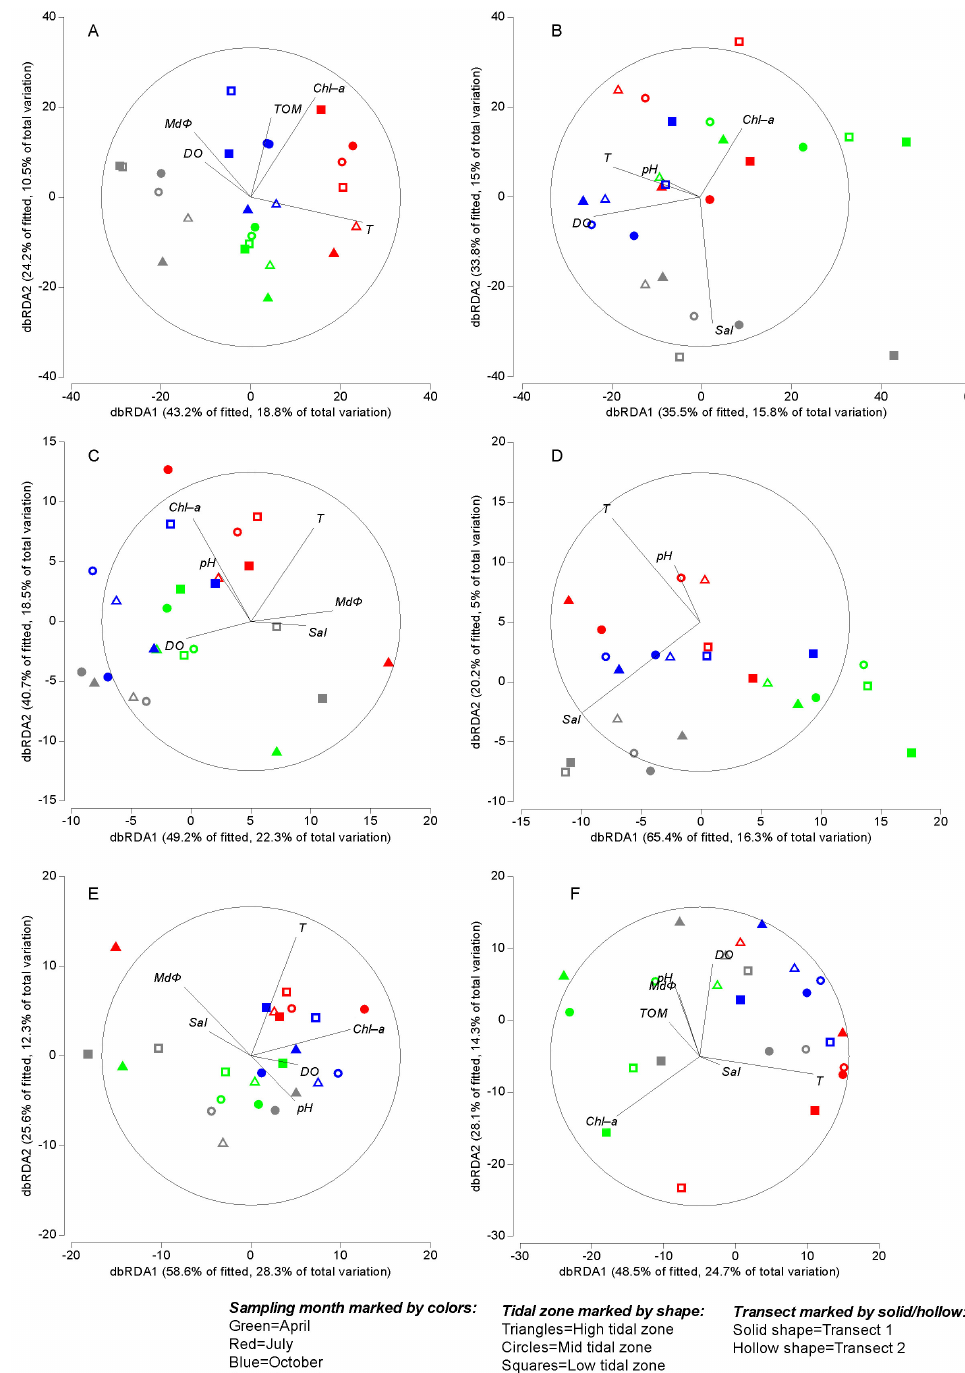
Figure 7. dbRDA ordination for the fitted model of nematode data (based on Bray–Curtis after fourth root transformation of abundances) versus environmental variables at XB ( A , C , E ) and GB ( B , D , F ) separately. ( A – B ) species composition; ( C – D ) feeding types; ( E – F ) c–p classes. When categorical variables are included in a DistLM analysis, then the length of each categorical vector is a measure of the strength of the relationship between that category and the dbRDA axes.